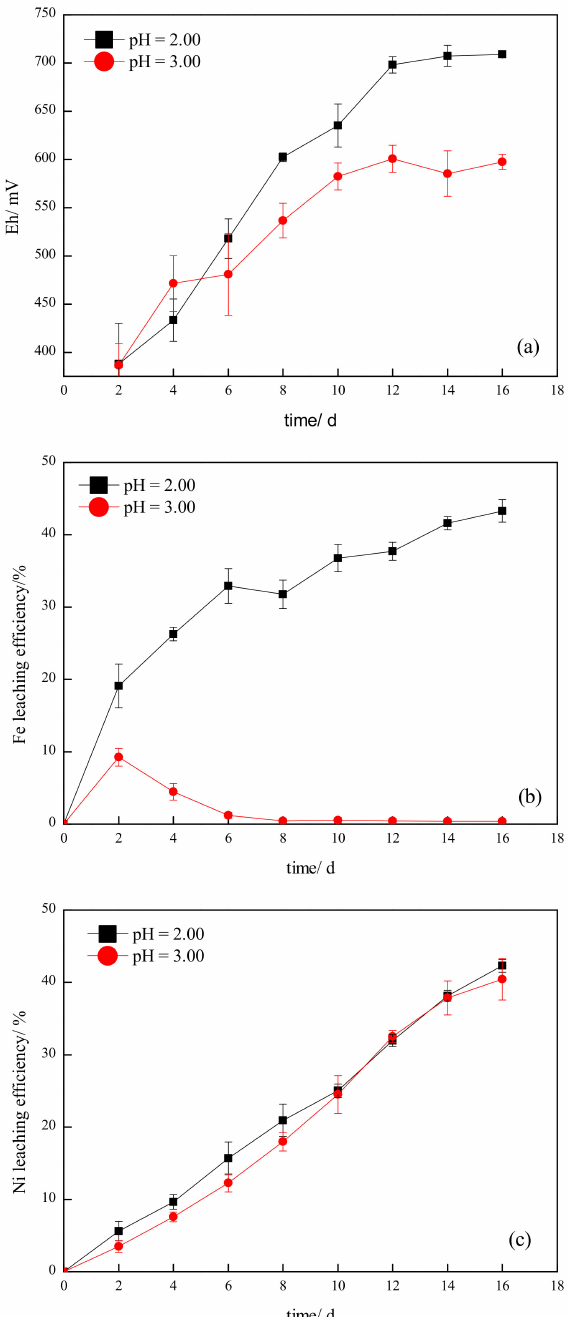
Figure 12. Changes in Eh ( a ), iron leaching e ffi ciency ( b ) and nickel leaching e ffi ciency ( c ) in solutions with